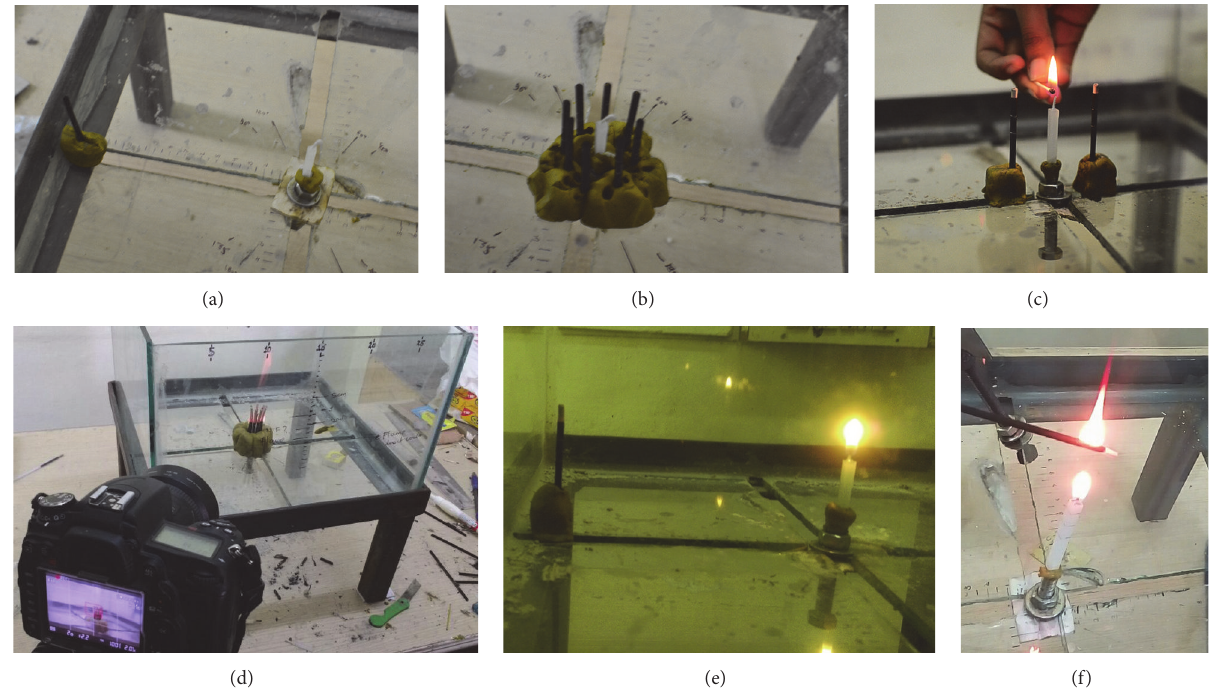
Figure 4: Pictorial view of experimental setup with (a) single-fuel configuration, (b) eight-fuel configuration, (c) ignition initiation, (d) video-graphed experimentation, (e) lateral direction smoldering, and (f) longitudinal direction